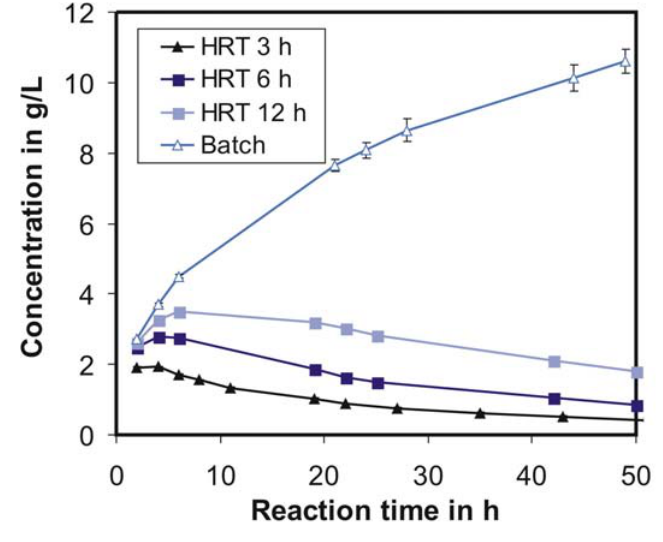
Figure 6. Product concentration profiles during cellulose conversion: comparison of parallel batch and continuous operations with different hydraulic residence times (HRT)